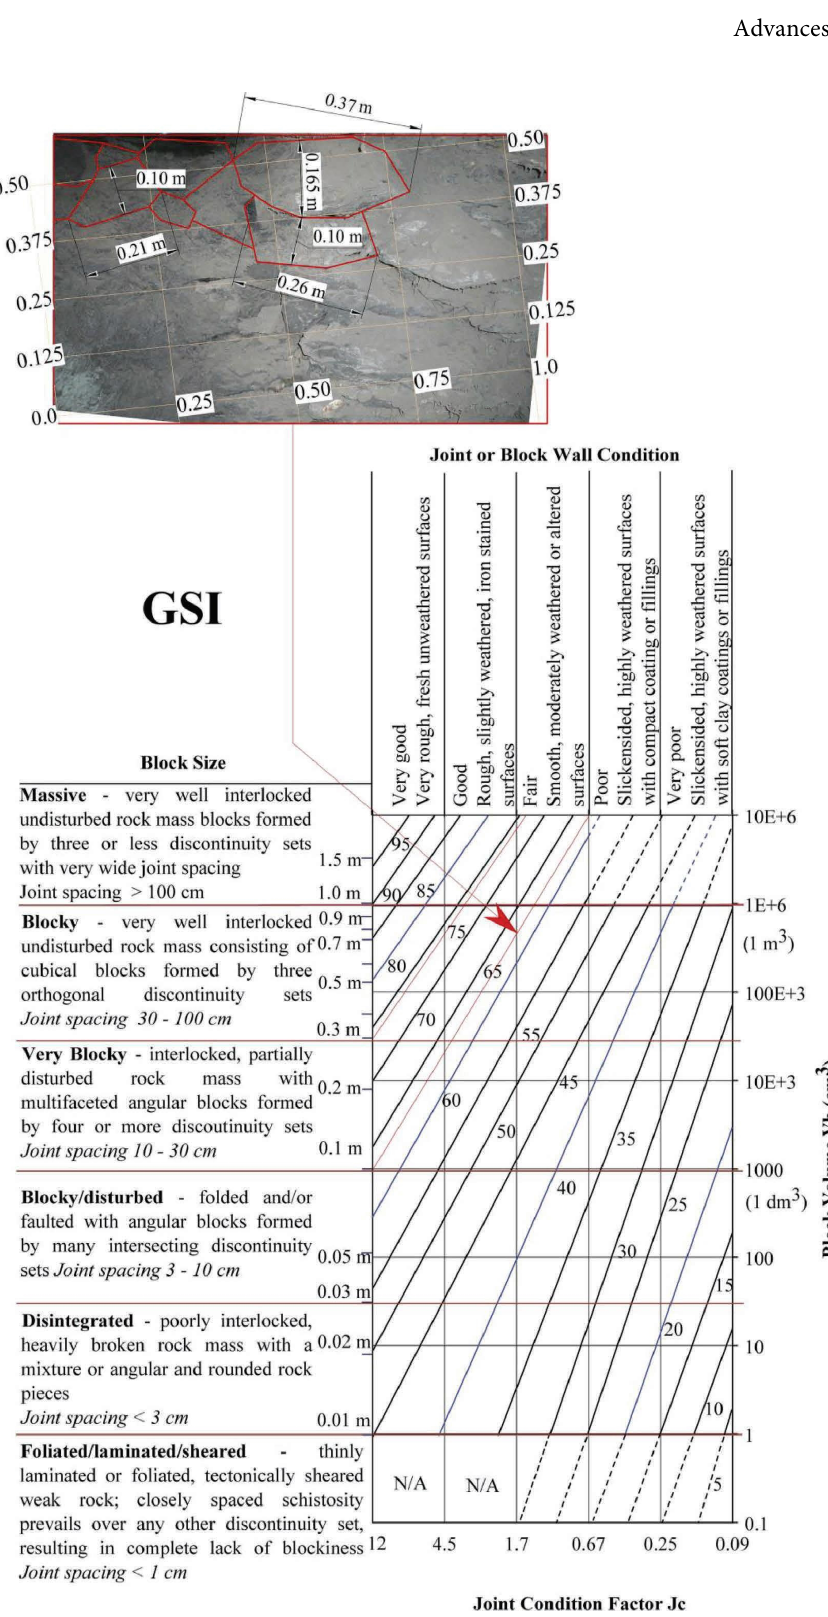
Figure 4: Quantifcation of GSI chart [33] with indicating region for the studied